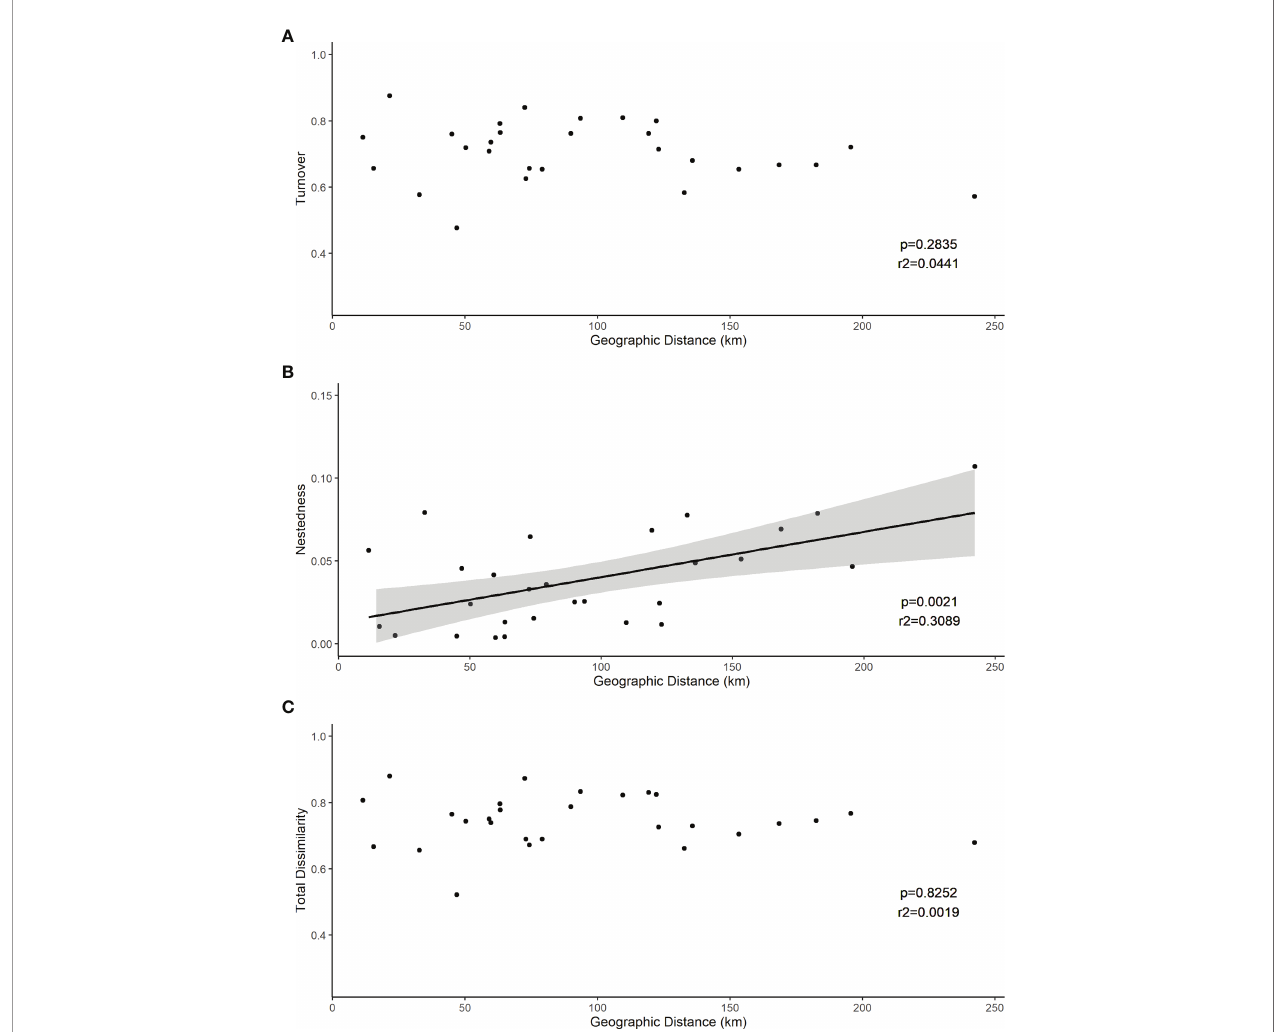
FIGURE 6 | Between-site distance decay relationships between betadiversity and geographic distance between sites. Both (C) total dissimilarity (Sorensen index, p<<0.001) and its component (A) turnover (p<<0.001) and (B) nestedness (p=0.0) are